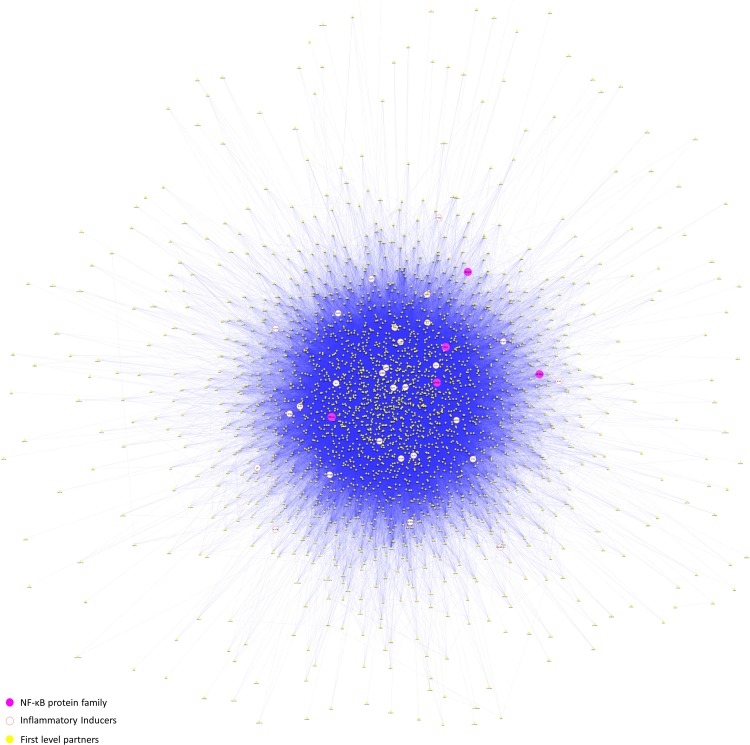
Significant protein interaction map.SPIN, developed from HINNF and their first level interacting partners.